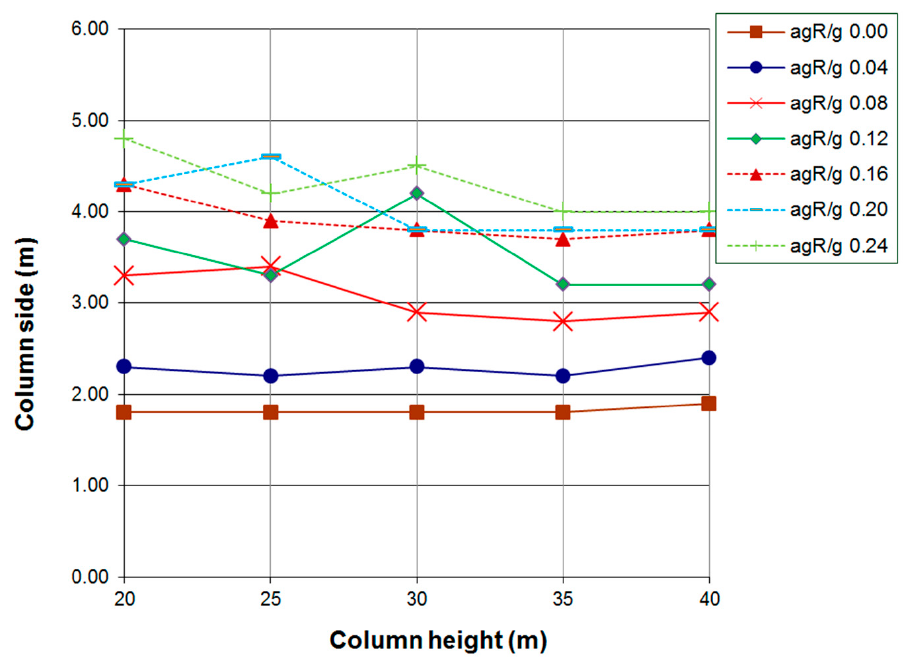
Figure 11. Width of the column versus height of the column.